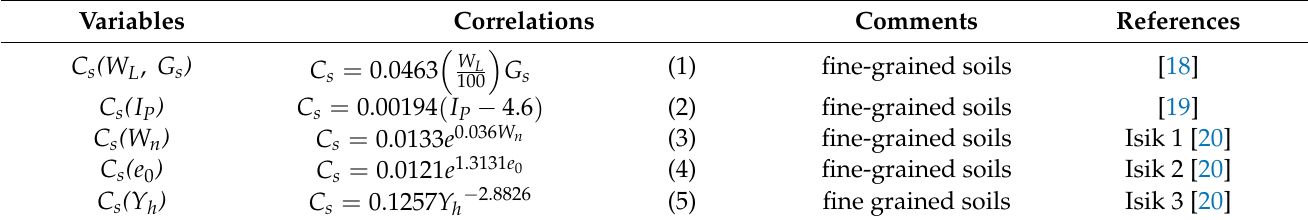
Table 1. Correlations proposed in the literature to estimate the swelling index C s . Variables Correlations